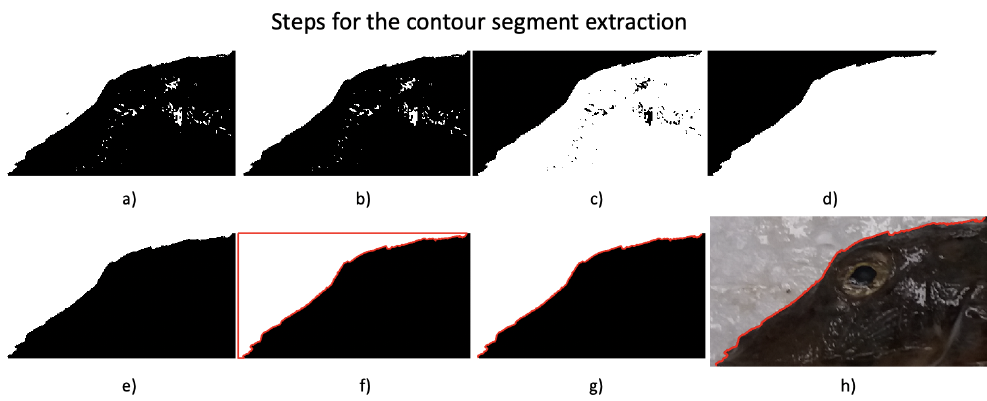
Figure 6. Steps for the contour segment extraction. In ( a ), binarization; in ( b – e ), the steps to fill the gaps in the background and in the fish regions; in ( f ), the boundary detection of the white region; and in ( g ), the contour of interest found after removing the image borders.